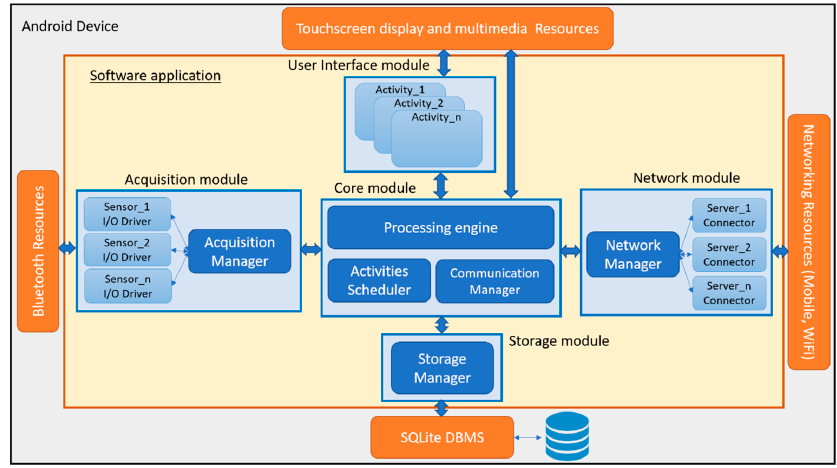
Figure 2. Architecture of the gateway software application.